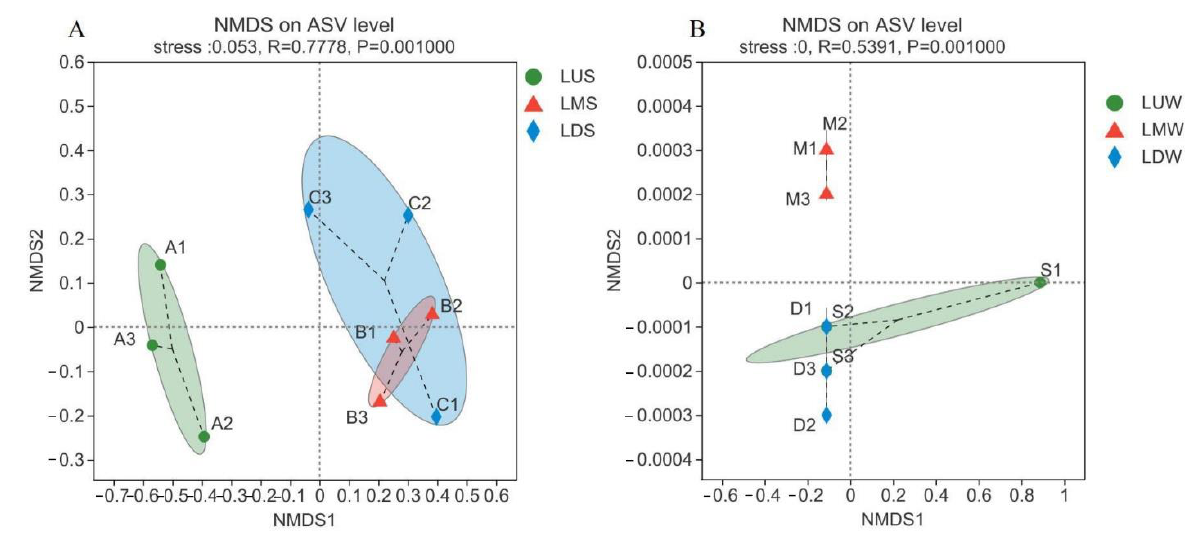
Figure 2. NMDS of Spartina alterniflora -associated samples based on Bray-Curtis matrices at the ASV level. ( A ) indicates the summer group and ( B ) indicates the winter group. The centroid of each ellipse represents the group mean, and the shape was defined by the covariance within each group. The data were analyzed by the ANOSIM group difference test based on the Bray-Curtis distance algorithm for multiple comparisons. LUS: summer samples of upper leaves; LMS: summer samples of middle leaves; LDS: summer samples of lower leaves; LUW: winter samples of upper leaves; LMW: winter samples of middle leaves; LDW: winter samples of lower